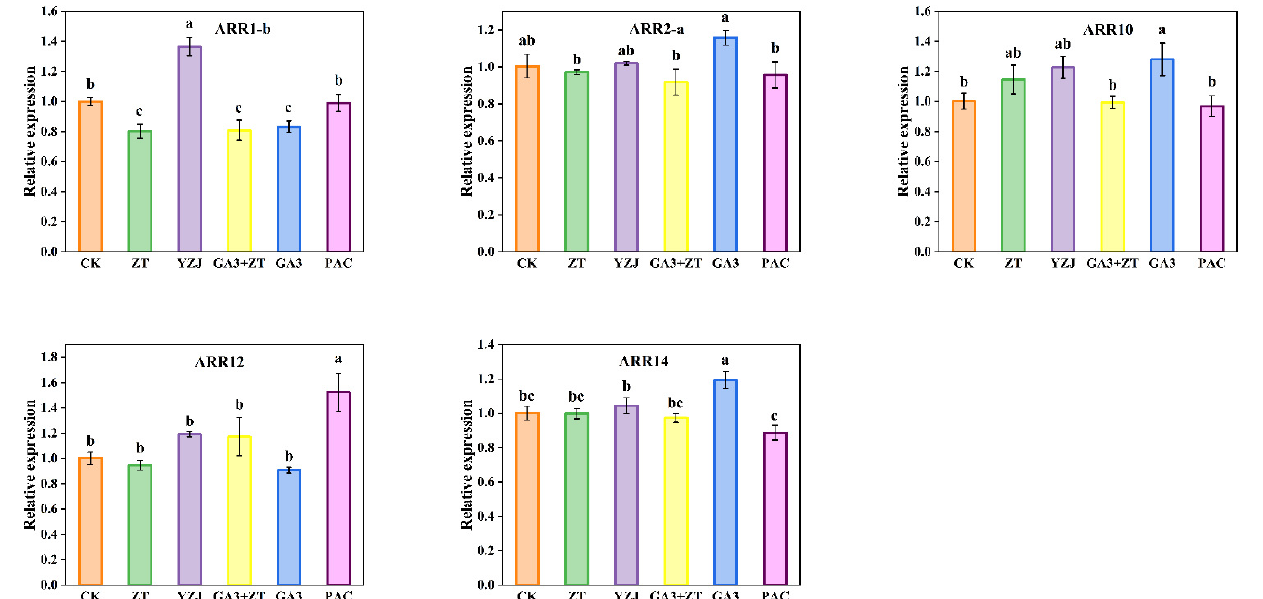
Figure 12. Five BcARR-B genes were analyzed by qRT-PCR expression in stem tip of flowering Chinese cabbage at bud emergence stage under different hormone treatments. Data represent the mean ± standard error for three biological experiments, with standard errors shown as bar charts above the columns, while lowercase letters indicate significance at p < 0.05.